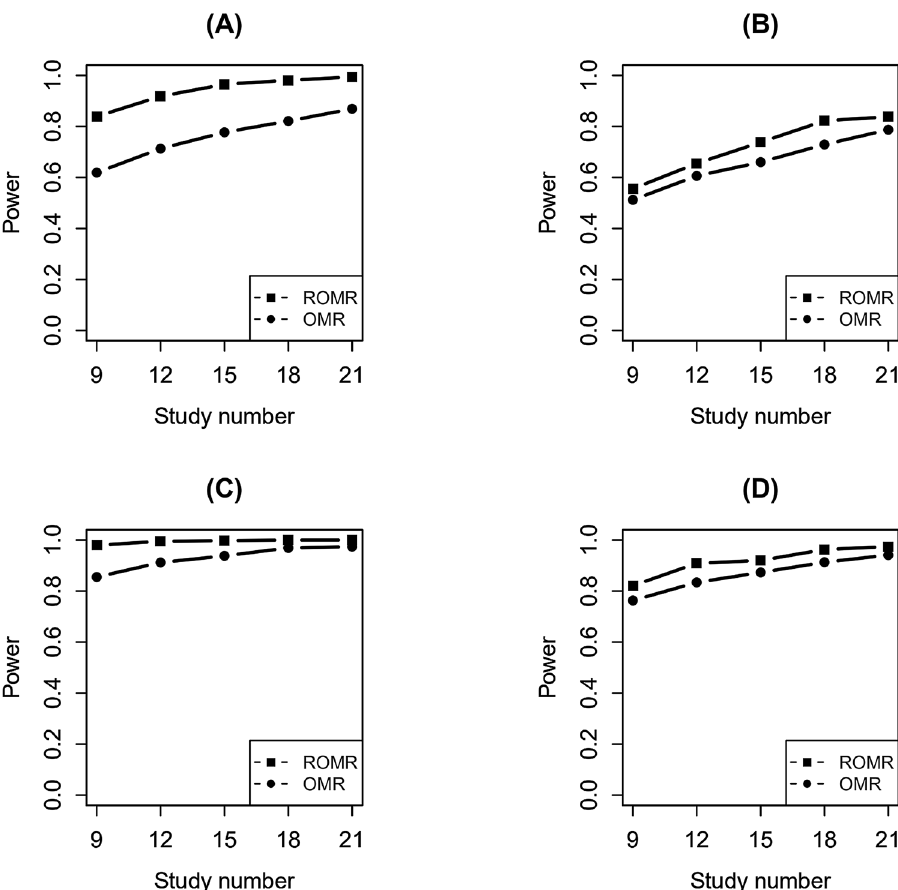
Figure 4. Statistical power of the test for SNP-environment interaction effects and the joint test for SNP and SNP-environment interaction effects with different number of studies (9, 12, 15, 18, 21) and with 100 and 400 overlapping individuals under a fixed heterogeneity. ( A , B ) The tests for SNP-environment interaction effects with different number of studies (9, 12, 15, 18, 21) and with 100 and 400 overlapping individuals under a fixed heterogeneity. ( C , D ) The joint tests for SNP and SNP-environment interaction effects with different number of studies (9, 12, 15, 18, 21) and with 100 and 400 overlapping individuals under a fixed